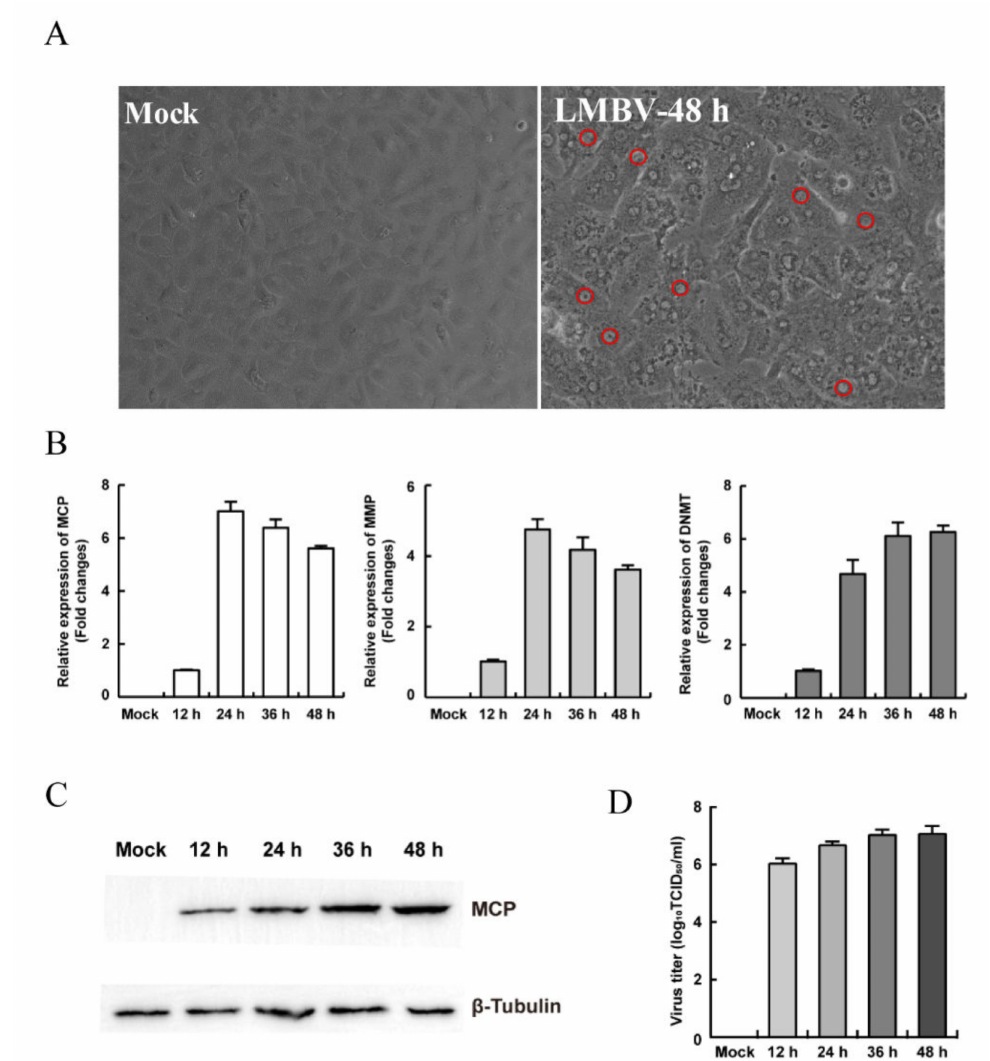
Figure 2. The susceptibility of MsF cells to fish viruses. ( A ) The cytopathic effects of MsF cells induced by LMBV. The red circles indicate the “vacuole”-like structures in LMBV-infected cells. ( B ) The transcription levels of viral genes in LMBV-infected MsF cells. ( C ) The protein synthesis of MCP in LMBV-infected MsF cells. ( D ) Virus production in LMBV-infected MsF cells at different infection